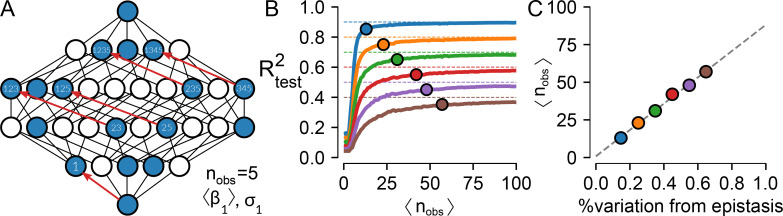
Epistasis as uncertainty.A) Schematic of a generic, partially characterized map. The nodes represent genotypes, some of which have been measured (blue) whereas others have not (white). Lines represent single point mutations. Given these observations, we measure the effect of “mutation 1” in five different backgrounds (red arrows) and can thus calculate the mean and variance in its effect across the map (〈β1〉 and σ1). B) R2test versus the average number of times each mutation is seen in sampled genotype-phenotype maps with epistasis responsible for 10% (blue) to 60% (brown) of the variation in the maps. Points indicate where the R2test is within 5% of the maximum predictive power of the additive model. C) A calibration curve indicating how many times, on average, one must observe each mutation in a map to resolve the additive coefficients with different fractions of epistasis.